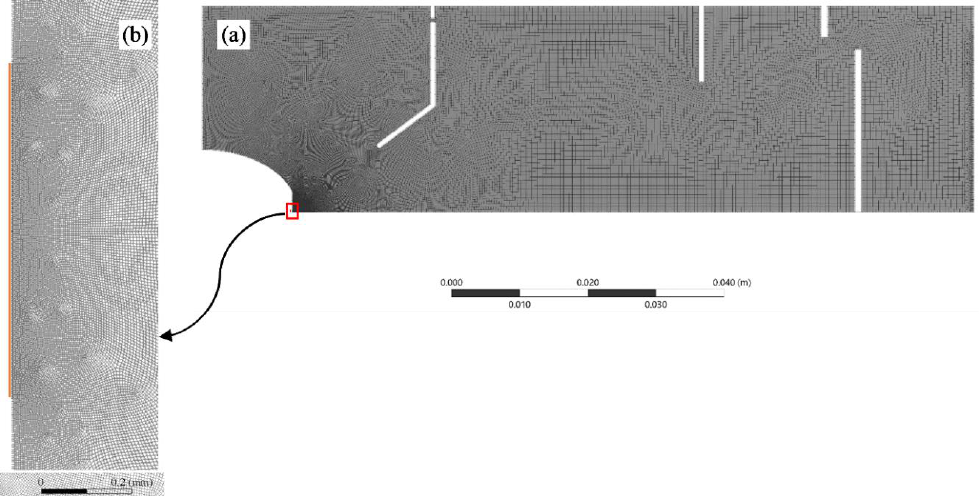
Figure 2. ( a ) View of the mesh of the burner used in 2D axisymmetric model (half of the burner geometry), including nozzle for inlet gas, ring cone, ring cup, and the mixing plate; ( b ) closer view of the refined mesh near the nozzle outlet.